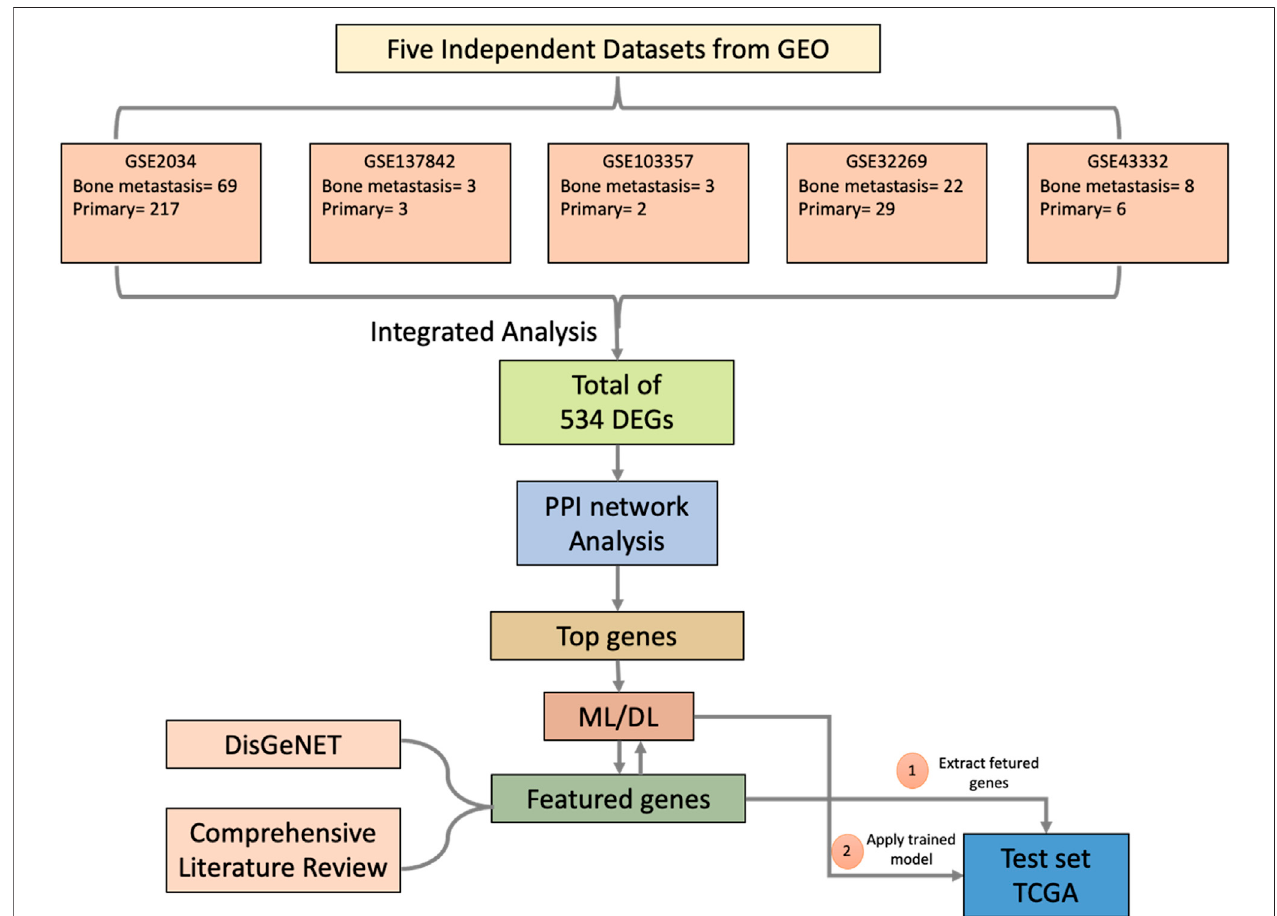
FIGURE 1 | A Flowchart description of the study